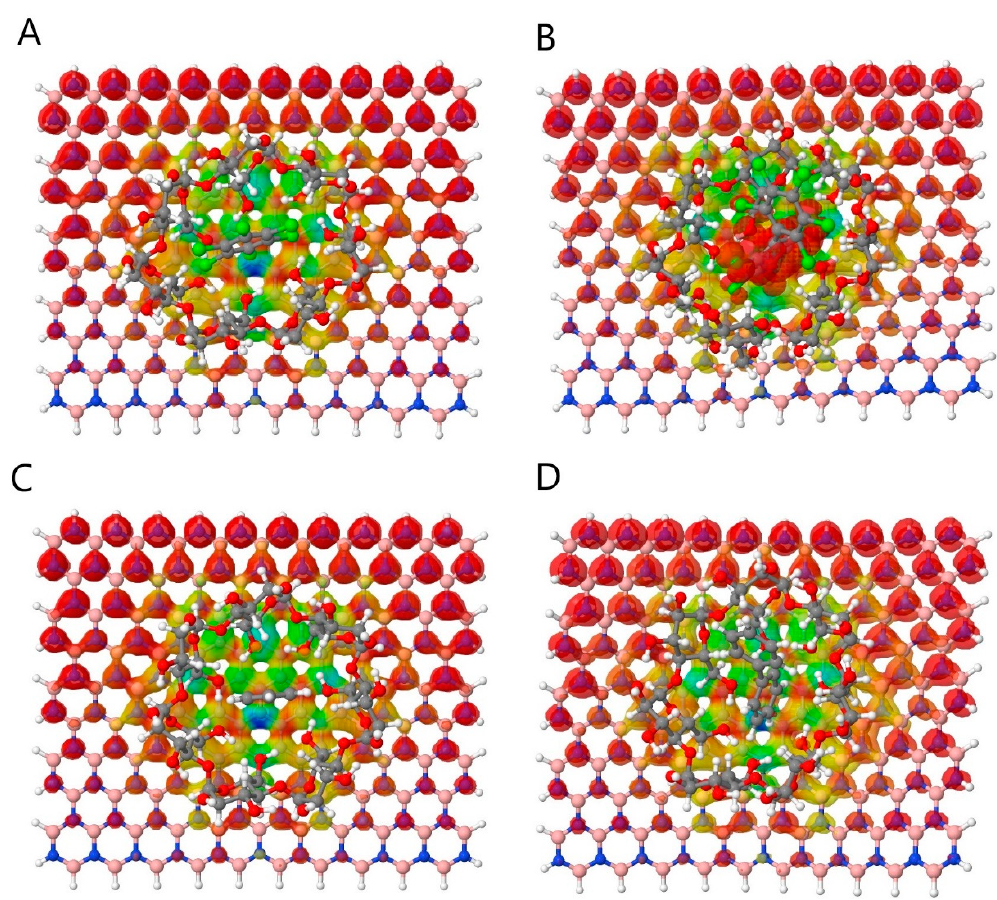
Figure 4. Frontier molecular orbital electrophilic susceptibility of ( A ) hexachlorobenzene (cb), ( B ) decachlorobiphenyl (pcb), ( C ) benzene (b), and ( D ) biphenyl (bp) adsorbed on carbon-doped hexagonal boron nitride (h-BN-CC2) decorated with beta-cyclodextrin (BCD).